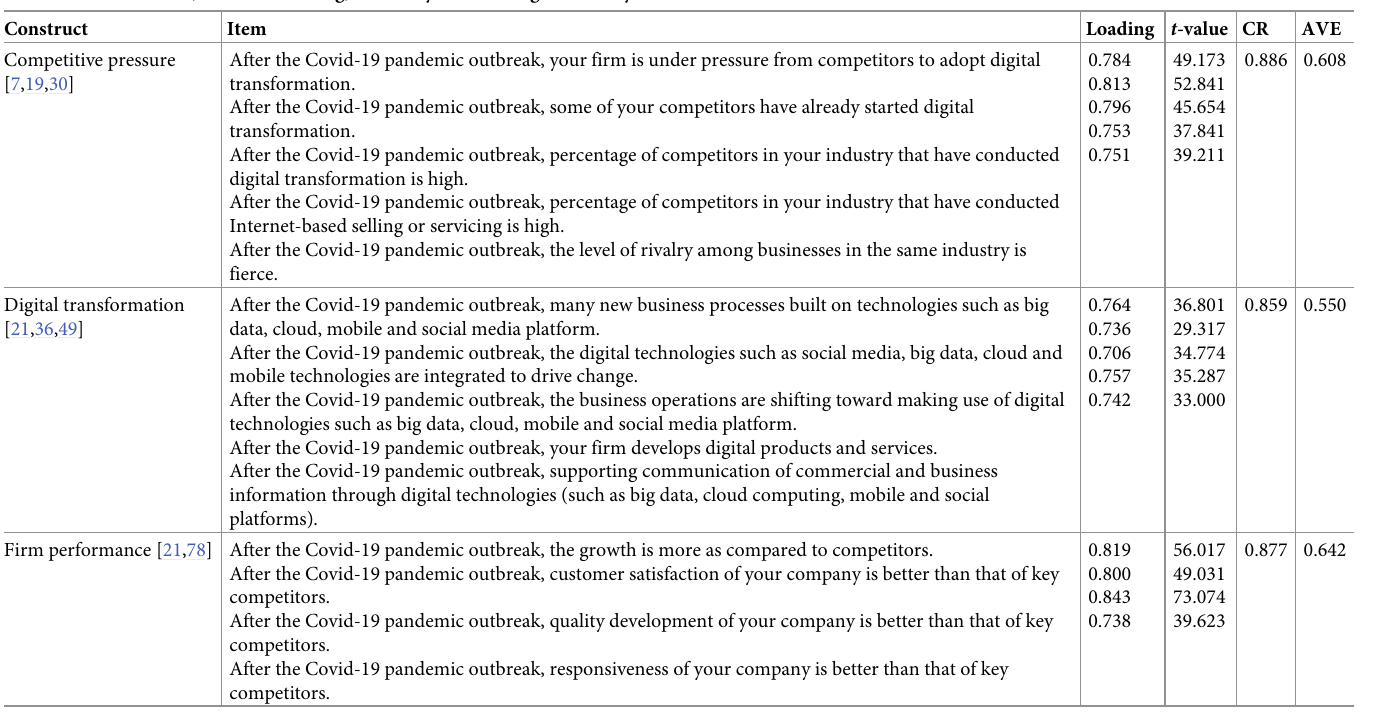
the PLS model were over those from the LM [93]. Thus, it can be concluded that this research model in Study 1 is a satisfactory model, as the PLS-based prediction showed a more accurate out-of-sample predictive power. This study executed some assessment procedures to evaluate the outcomes of structural model including multicollinearity between constructs and relevance of the path coefficients. Table 4. Loadings and